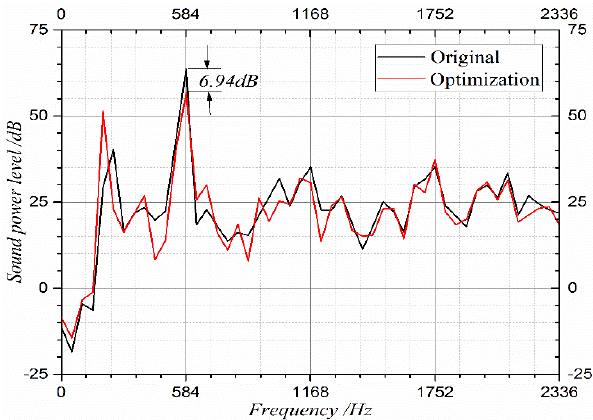
Figure 31. The frequency spectrum of total acoustic power of the volute surface.